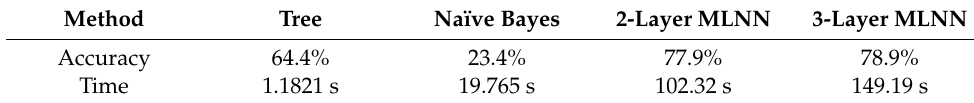
Table 3. Machine learning techniques accuracy for material